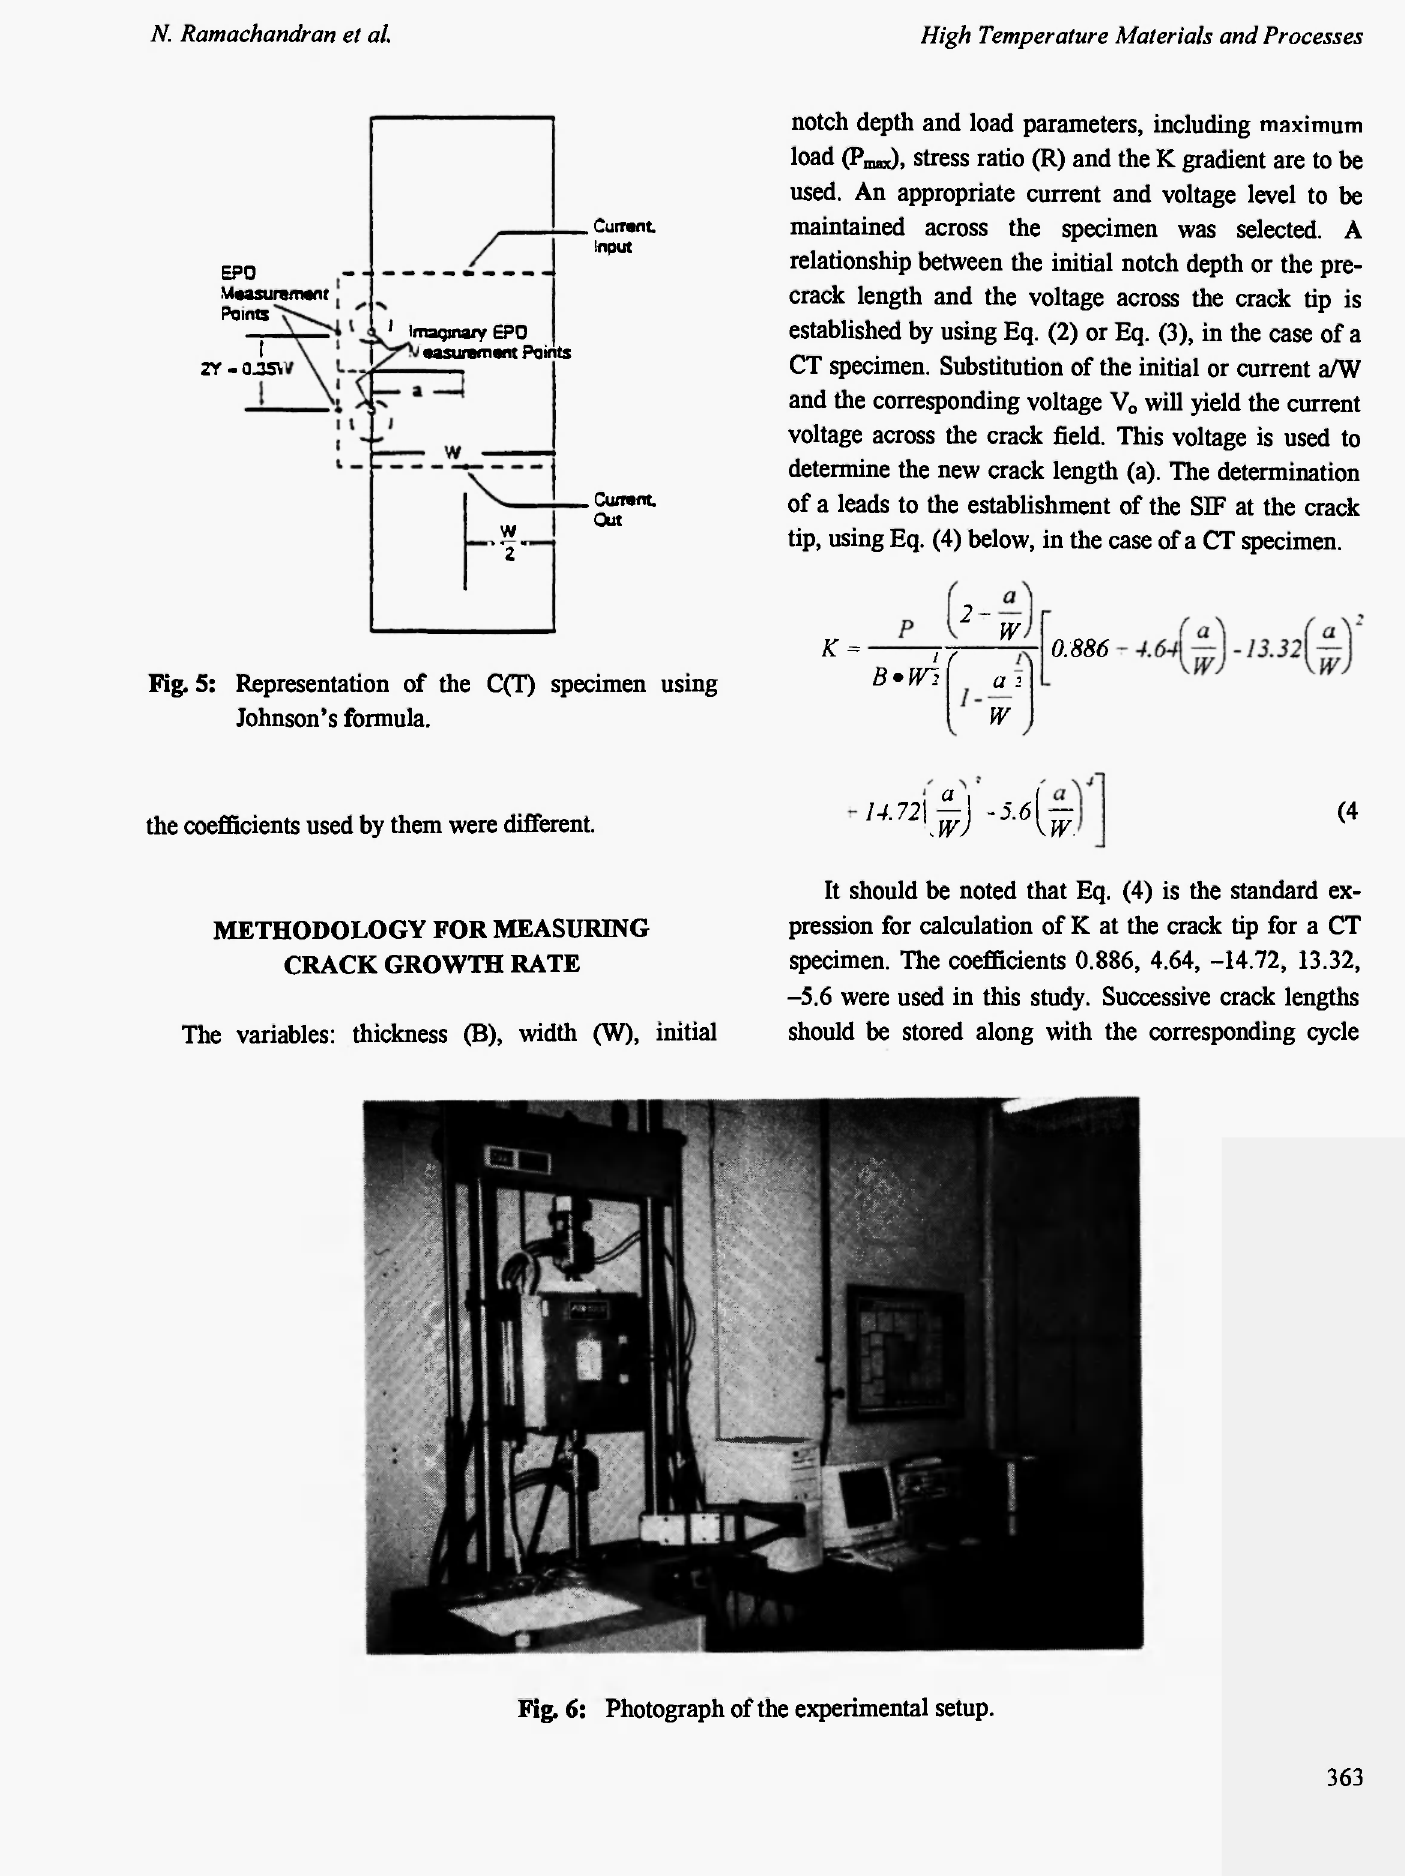
Fig. 6: Photograph of the experimental